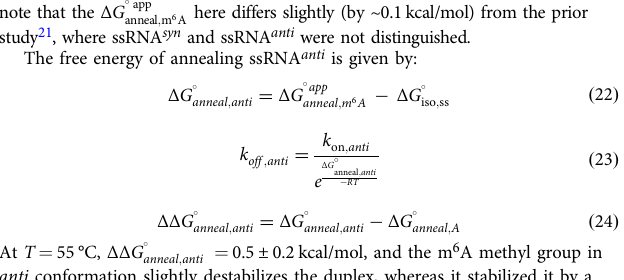
three-state fi t to the dsGGACU m 6 A m 6 A-C2 RD data (Fig. 3a and Supplementary Table 3) using the triangular topology at T = 55°C or from RD measurements done on the hairpin constructs at T = 65°C (Supple- mentary Fig. 6a). C8 Δ ω ds, syn = 0 because C8 is not sensitive to methylamino isomerization (Supplementary Fig. 6a). C8 R 1 (dsRNA syn ) = R 1 (dsRNA anti ) = R 1,GS , and R 2 (dsRNA syn ) = R 2 (dsRNA anti ) = R 2,GS were obtained from a two-state fi t to the dsGGACU m 6 A m 6 A-C8 RD data (Supplementary Table 1), Δ ω ss ; syn is obtained from the two-state fi t of the CEST RD data probing duplex melting at T = 65 and 55°C 21 . 2. The equilibrium populations p ð ssRNA syn Þ ; p ð dsRNA syn Þ ; p ð dsRNA anti Þ were obtained from kinetic simulations (see differential equations below) that were suf fi ciently long to ensure equilibration: